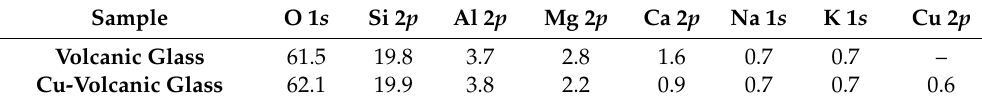
Table 2. Atomic concentration on the surface (%).